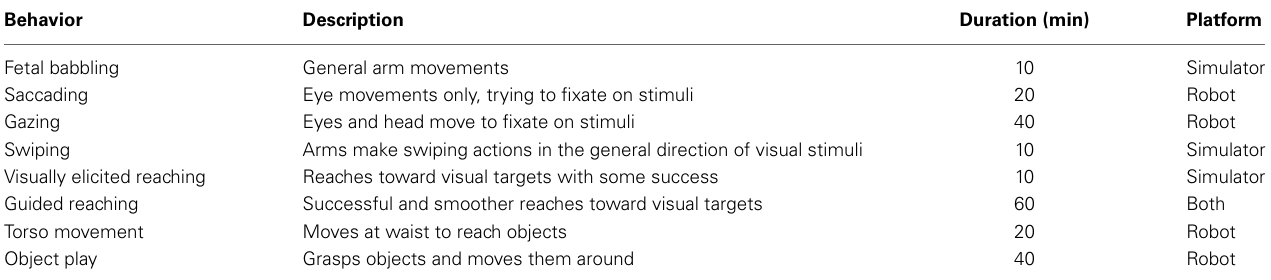
Table 5 | Observable experimental behaviors.